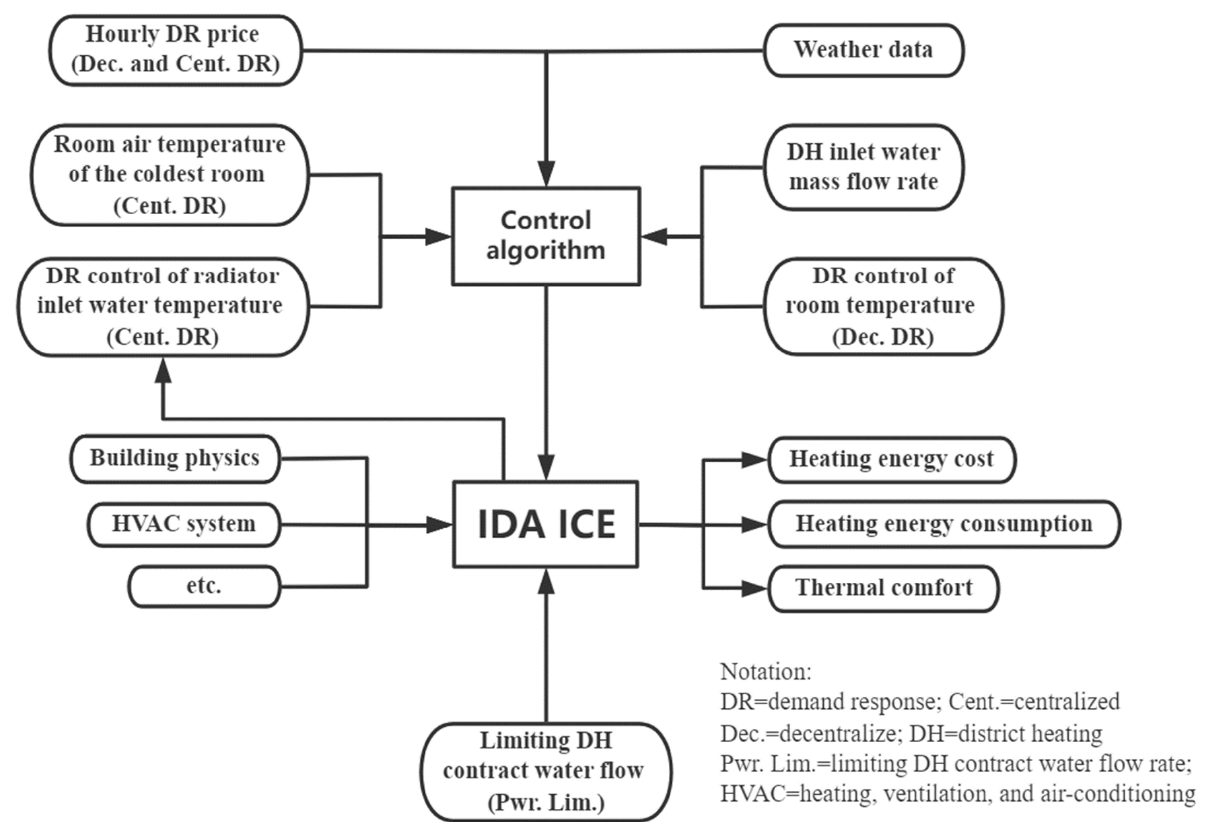
Figure 1. Simulation process principle for decentralized and centralized DR controls and peak demand limiting.